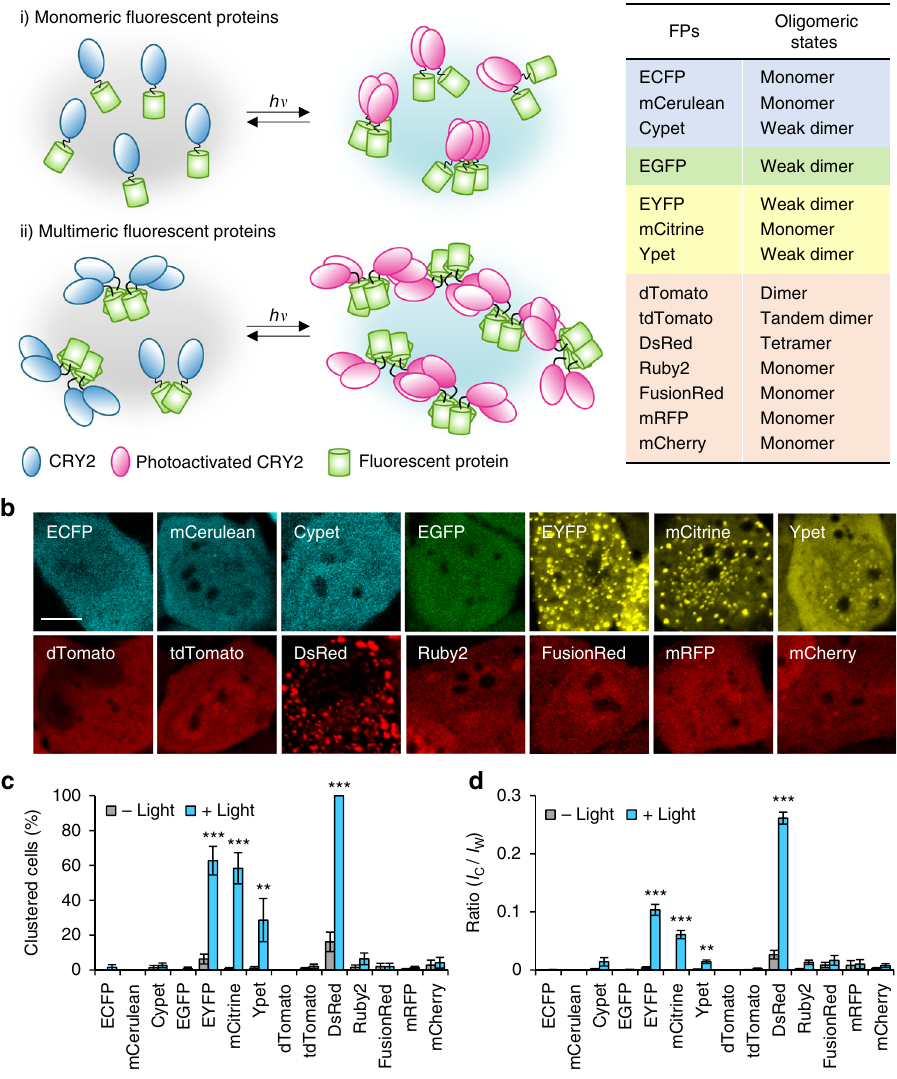
Fig. 1 Effect of quaternary structures of FP tags on the ef fi ciency of light-induced CRY2 clustering. a Schematic diagram for visualizing relationships between quaternary structures of FPs and ef fi ciency of CRY2 clustering. Right , lists of characteristics of FPs used in this research. b Fluorescence images of HeLa cells transfected with expression plasmids for each FP-labeled CRY2PHR. Scale bar, 10 μ m. c Quanti fi cation of the percentage of clustered cells. ** P = 2.03 × 10 – 5 ; *** P = 4.11 × 10 – 17 (EYFP), 5.44 × 10 – 12 (mCitrine), 4.87 × 10 – 46 (DsRed) by Student ’ s two-tailed t -test. d Quanti fi cation of the cluster ratio in cells containing clusters. Total cluster intensity ( I C ) was divided by the total fl uorescence ( I W ) of the whole-cell. Values are expressed as means ± s.e.m. ( n = 122, 81, 127, 100, 188, 193, 223, 163, 174, 113, 140, 171, 187, 142 cells, three independent experiments). ** P = 8.36 × 10 – 6 ; *** P = 6.74 × 10 – 20 (EYFP), 1.66 × 10 – 13 (mCitrine), 4.87 × 10 – 46 (DsRed) by Student ’ s two-tailed t